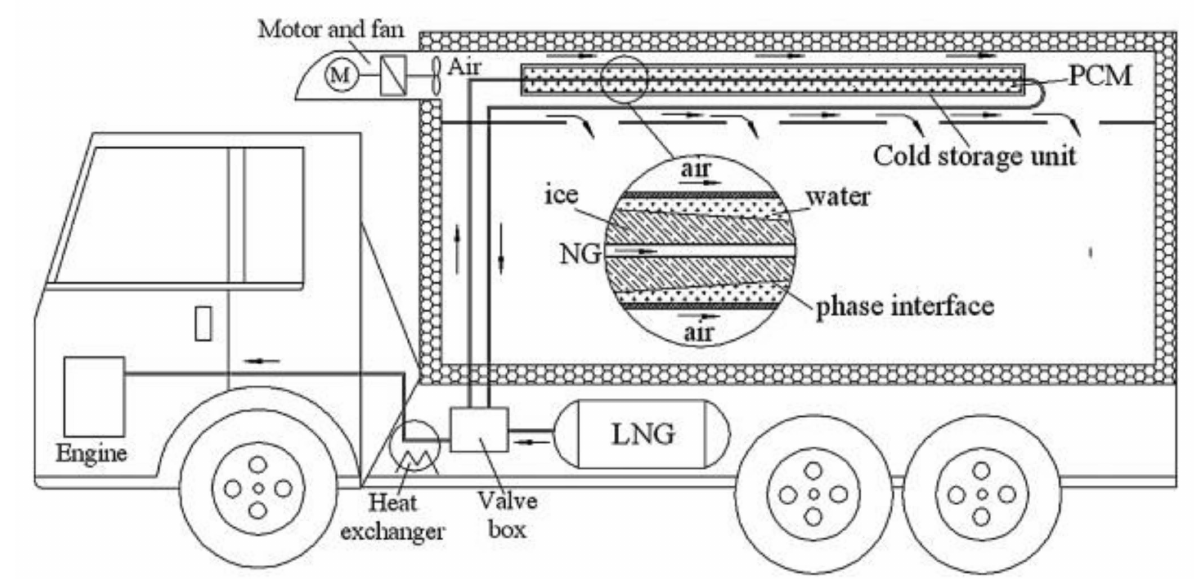
Figure 12. The Schematic diagram of the LNG refrigerated vehicle and the cold storage unit. Reprinted from ref. [50], Copyright (2010), with permission from Elsevier.